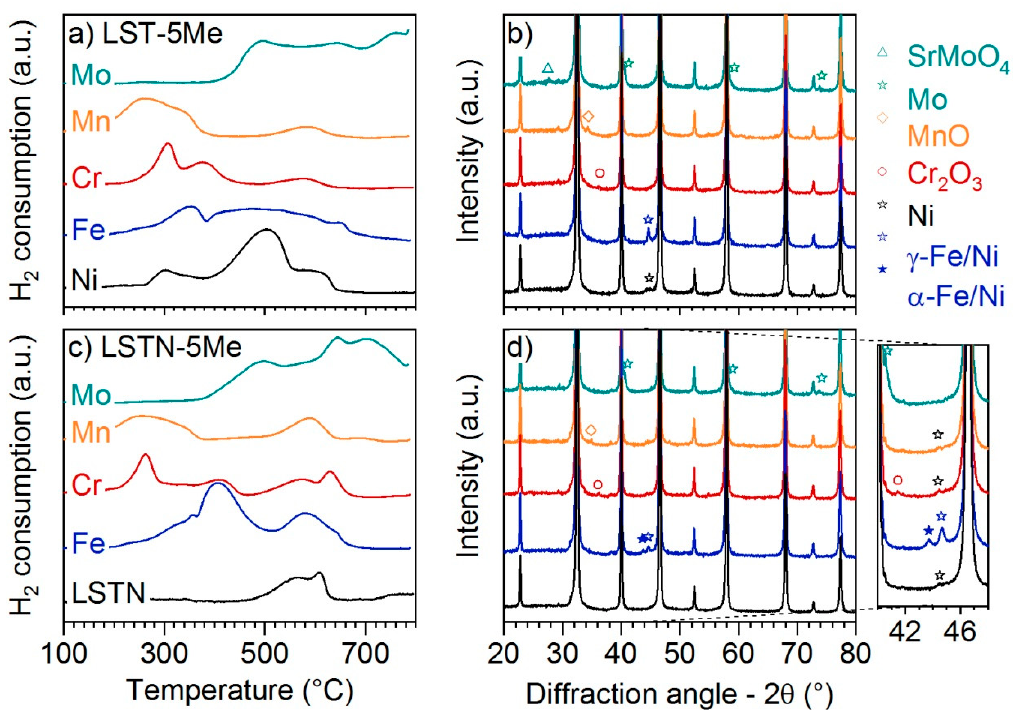
Figure 2. TPR profiles of ( a ) LST-5Me (Me = Mo, Mn, Cr, Fe, Ni) and ( c ) LSTN-5Me (Me = Mo, Mn, Cr, Fe). ( b ) Powder XRD patterns of reduced LST-type materials and ( d ) LSTN-type materials (10 vol%